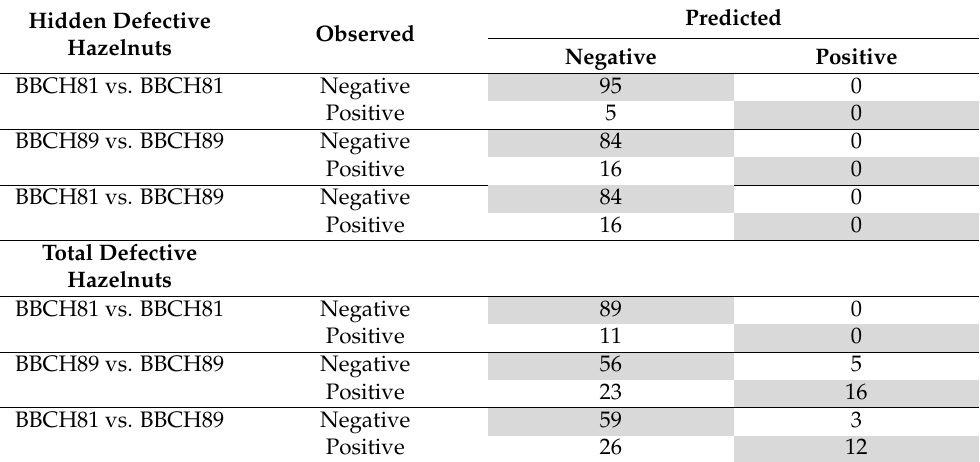
Table 3. Contingency matrix for model internal validation reported as model capability of correctly predicting defective hazelnuts (% of accurate predictions). A prediction is correct when the model prediction agrees with the observed data. We tested the model accuracy to predict hidden defective (HD) and total defective (TD) hazelnuts in three different comparison scenarios of predicted vs. correct predictions for each scenario; white cells on left indicate underestimates (observed positive and predicted negative values); white cells on right suggest overestimates (observed negative and predicted positive